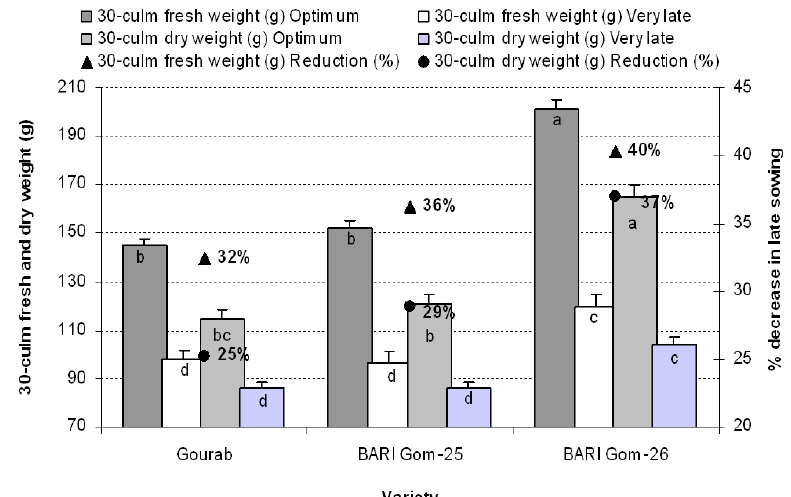
Fig. 9. 30-culm fresh and dry weights of 3 wheat varieties, sown under optimum and very late conditions. Mean (±SD) was calculated from three replicates for each treat- ment. Bars with different letters are significantly different at p ≤ 0.05 (LSD